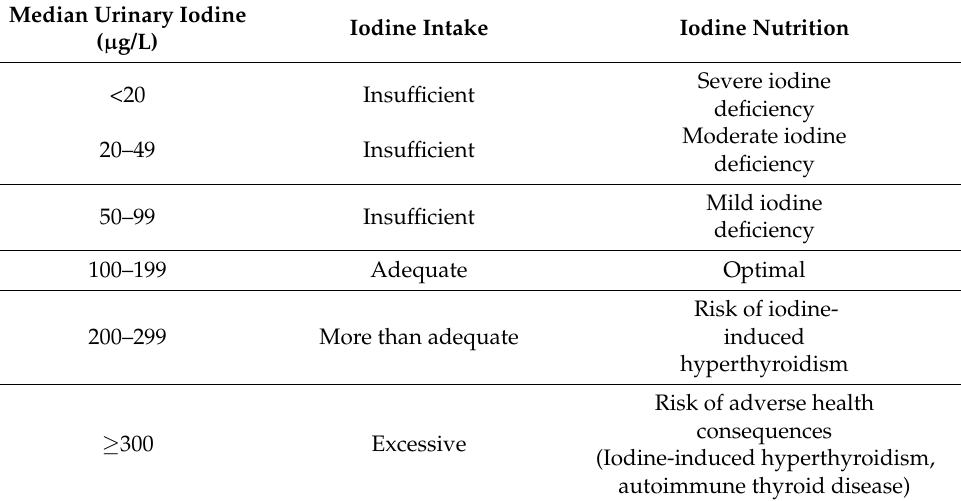
Table 6. Epidemiological criteria for the evaluation of iodine nutrition in a population based on median urinary iodine concentration in school-age children